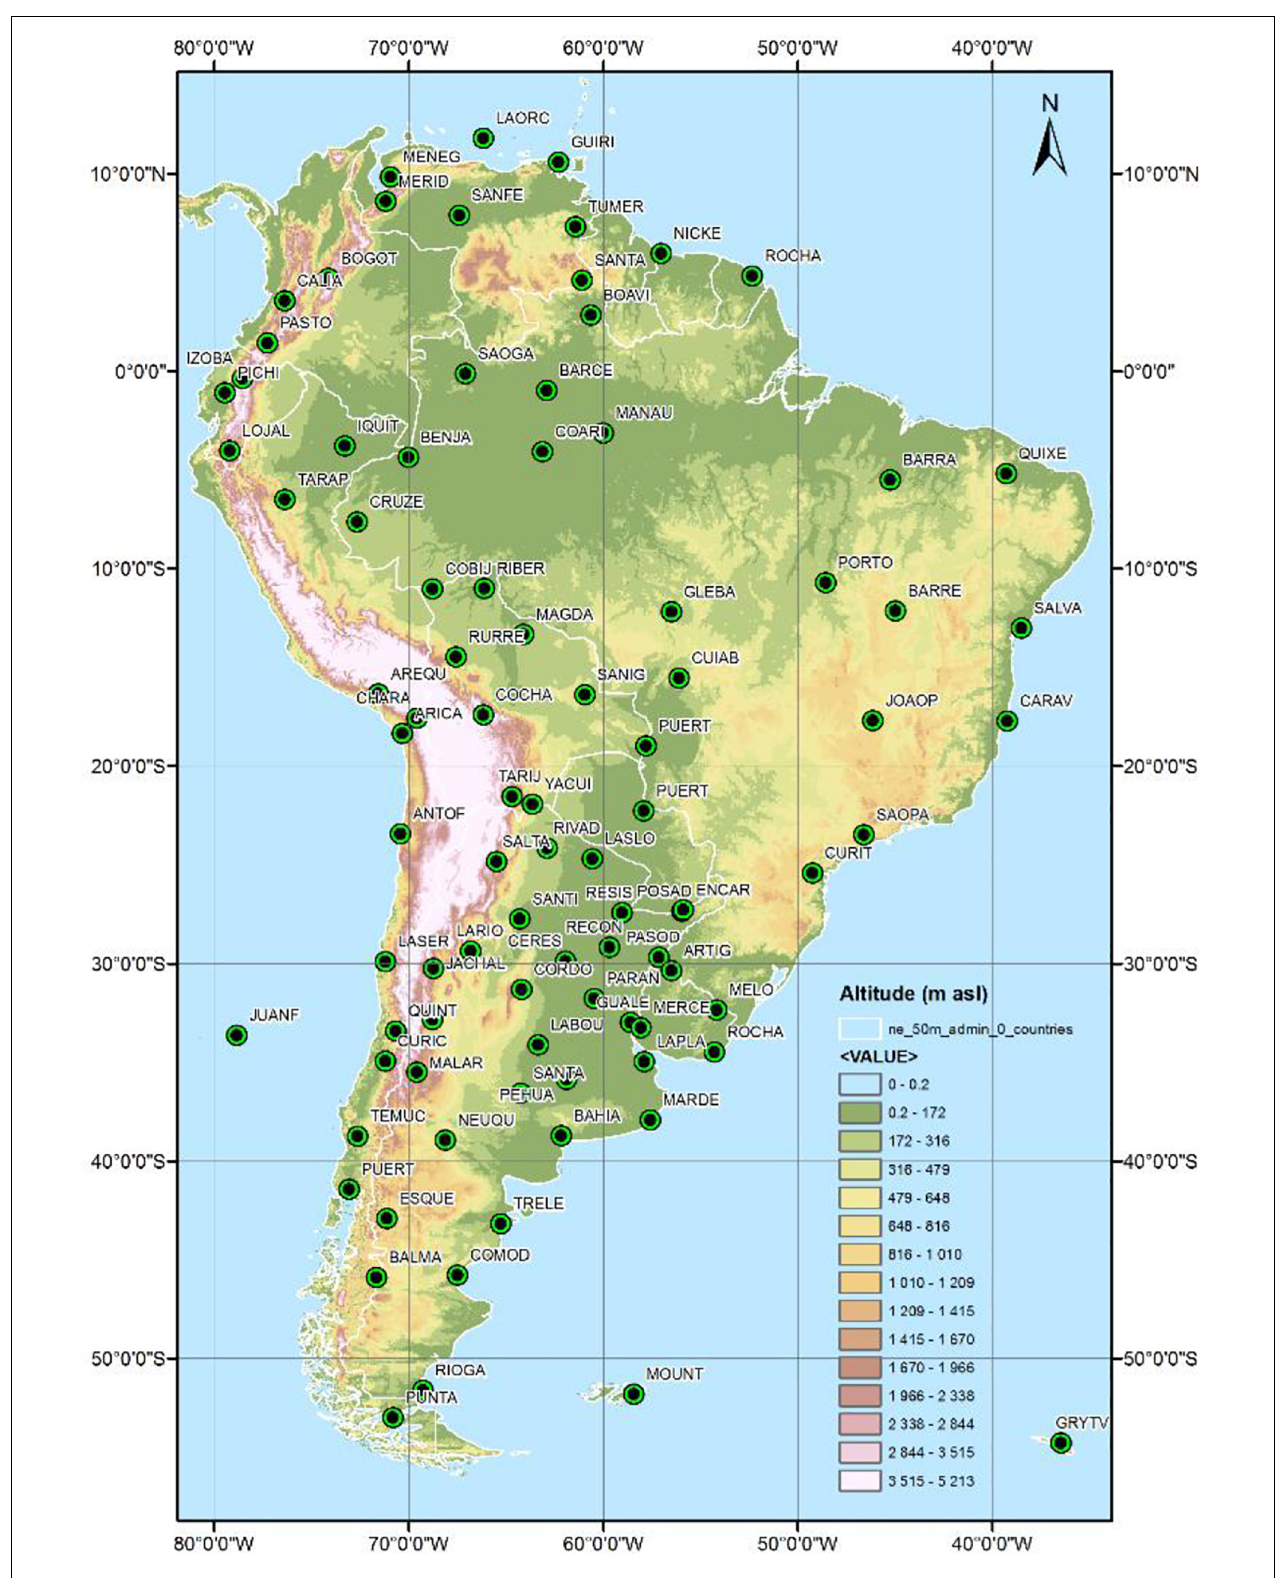
FIGURE 5 | GSN-stations (black points) in the CLIMAT